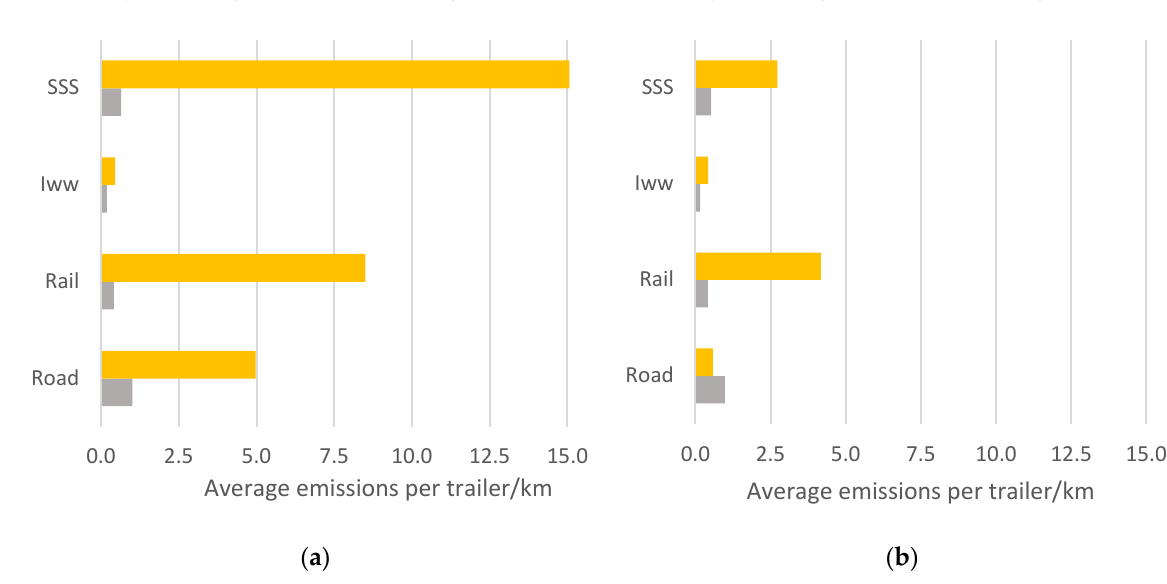
Figure 8. Average emissions per trailer per distance traveled in each mode in the corridor: ( a ) scenario 1; ( b ) scenario 2.